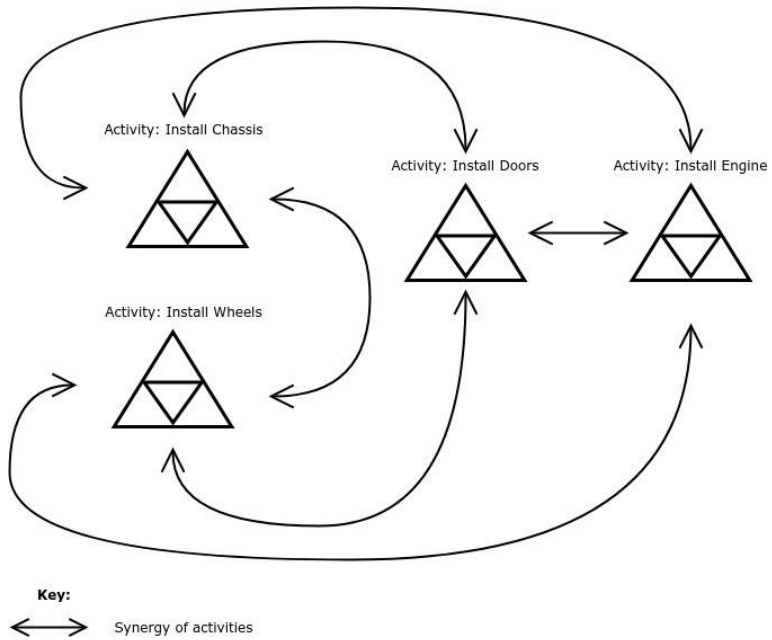
Figure 2. Representation of an NoA for a simplified “ ecology ” in a car assembly line.